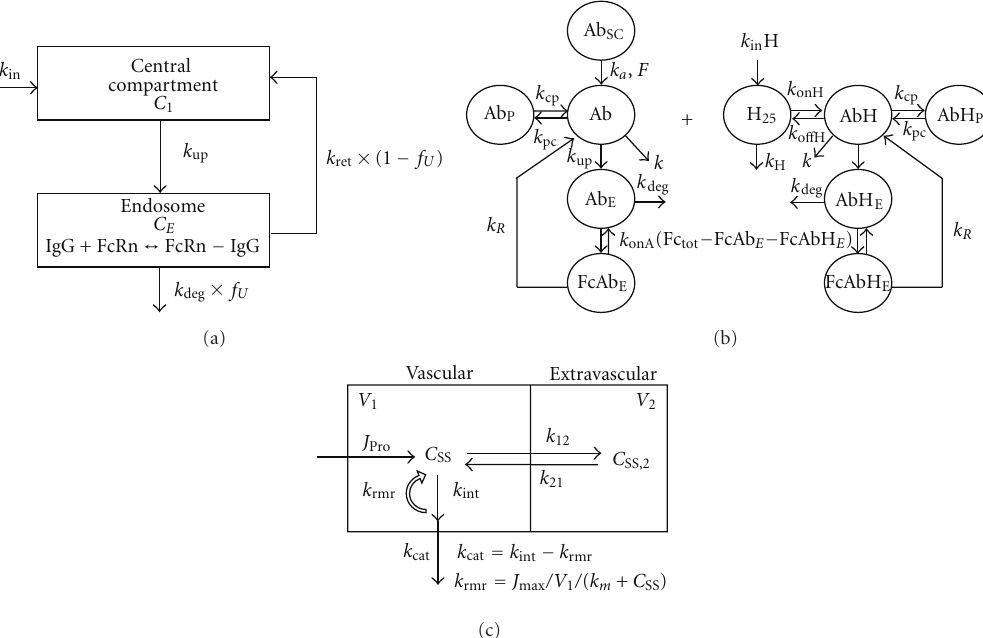
Figure 7: Published semimechanistic PK models. (a) Hansen’s model; (b) Xiao’s model; (c) Kim’s model. Models schemes are redrawn based on published papers.